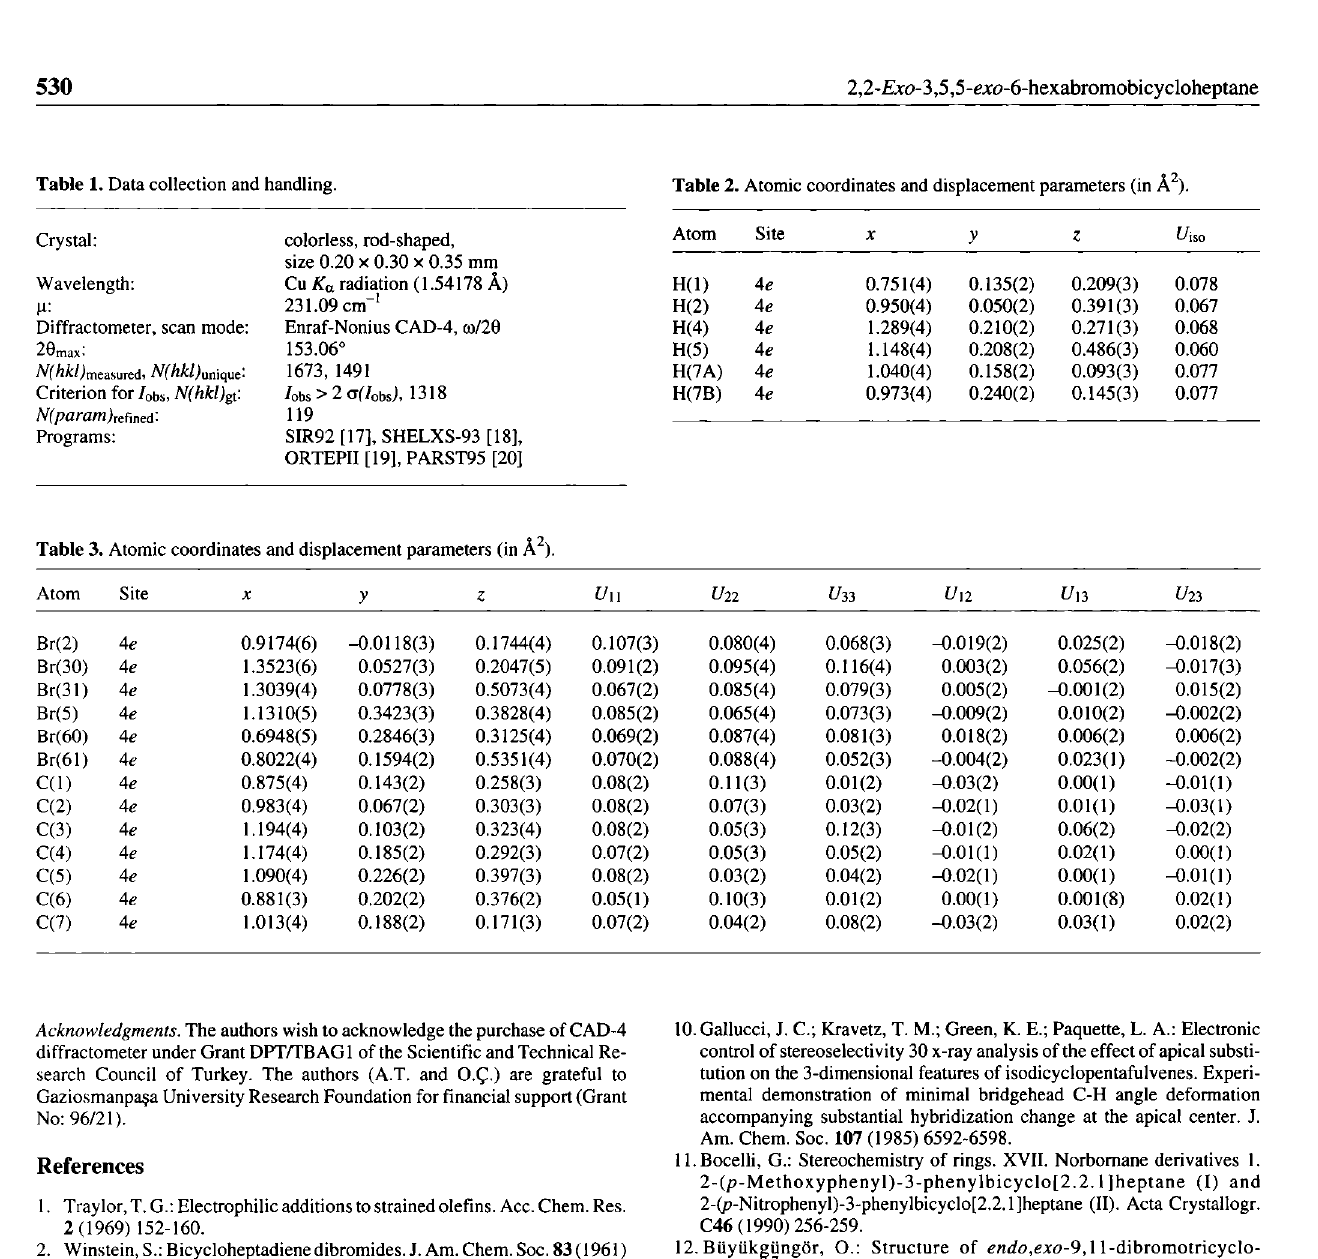
Table 1. Data collection and handling. Table 2. Atomic coordinates and displacement parameters (in A 2 ).